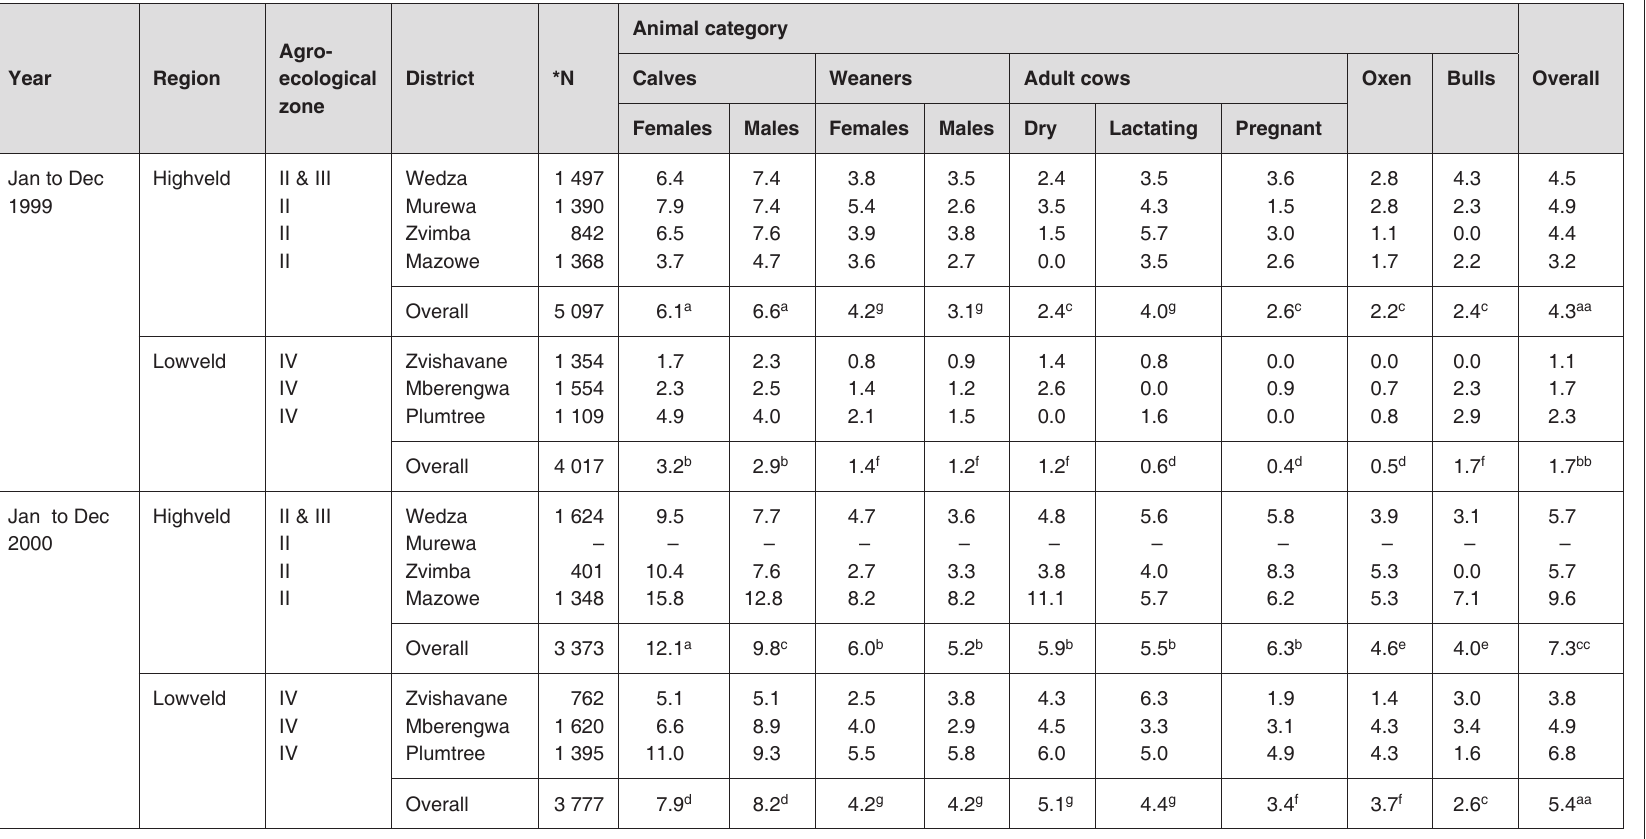
TABLE 2 Mean prevalence (%) of Schistosoma mattheei in the different categories of cattle by year, region and district in the highveld and lowveld communal grazing areas of Zimbabwe as from January 1999 to December